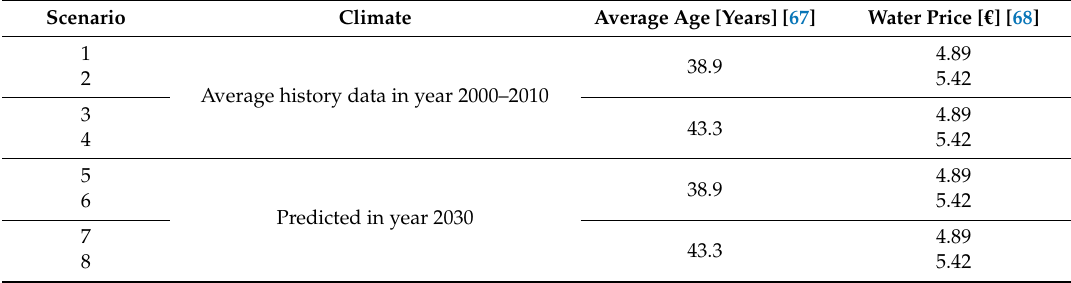
Table 8. Scenarios setting for Rainau, Baden-Württemberg, Germany.